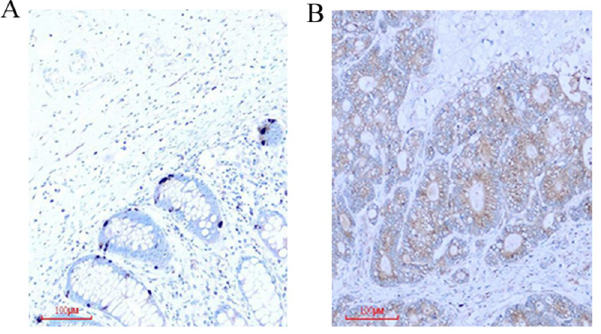
Fig 2. Immunohistochemical analysis of COPB2 in colorectal cancer specimens. (A) COPB2 was decreased expression in adjacent tissues. (B) Higher expression of COPB2 in cancer